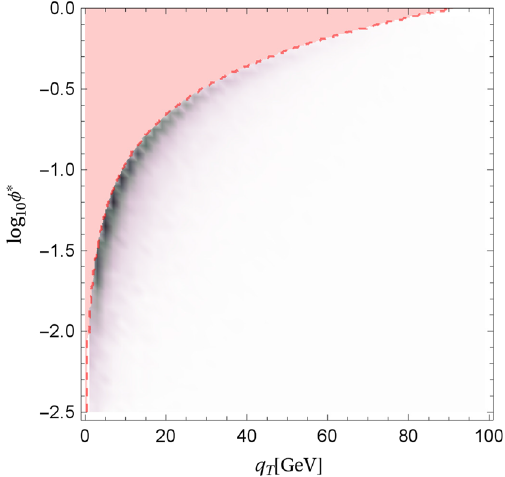
Fig. 11 The double differential cross section in q T and log 10 φ ∗ . The dashed red line corresponds to φ ∗ = q T / M Z , the maximum achievable value of φ ∗ for a given q T . In the red region above the dashed line, the cross section vanishes. Dark areas in the density plot correspond to large cross section. Most of the cross section arises from values of φ ∗ close to the kinematic boundary